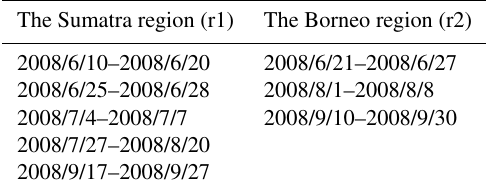
Table 2. The fire periods in the two study regions. The Sumatra region (r1) The Borneo region